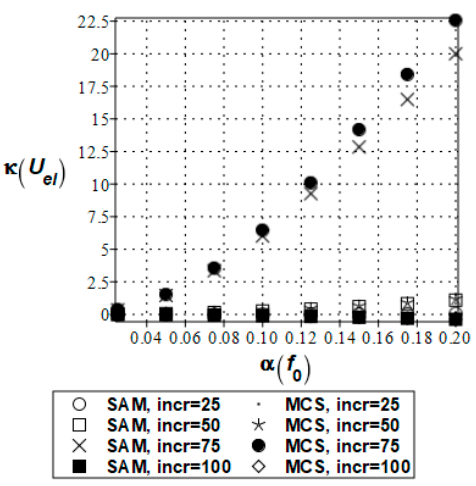
Figure 10. Skewness of plastic energy fluctuations.